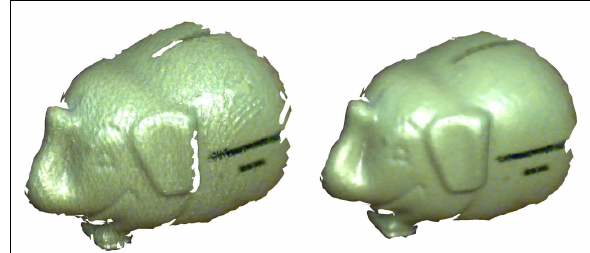
Figure 5: Textured scans after initial registration and after ICP.